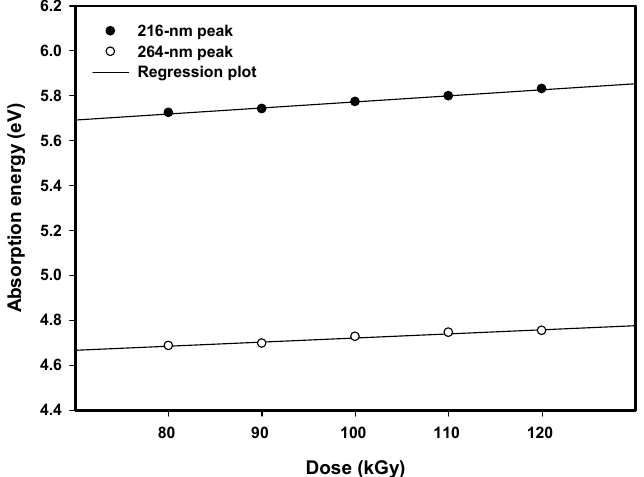
Figure 9. Absorption energy of 216 and 264-nm absorption peaks of Pt nanoparticles increased with increasing dose from 80 to 120 kGy owing to a reduction in particle size from 5.3 to 3.4